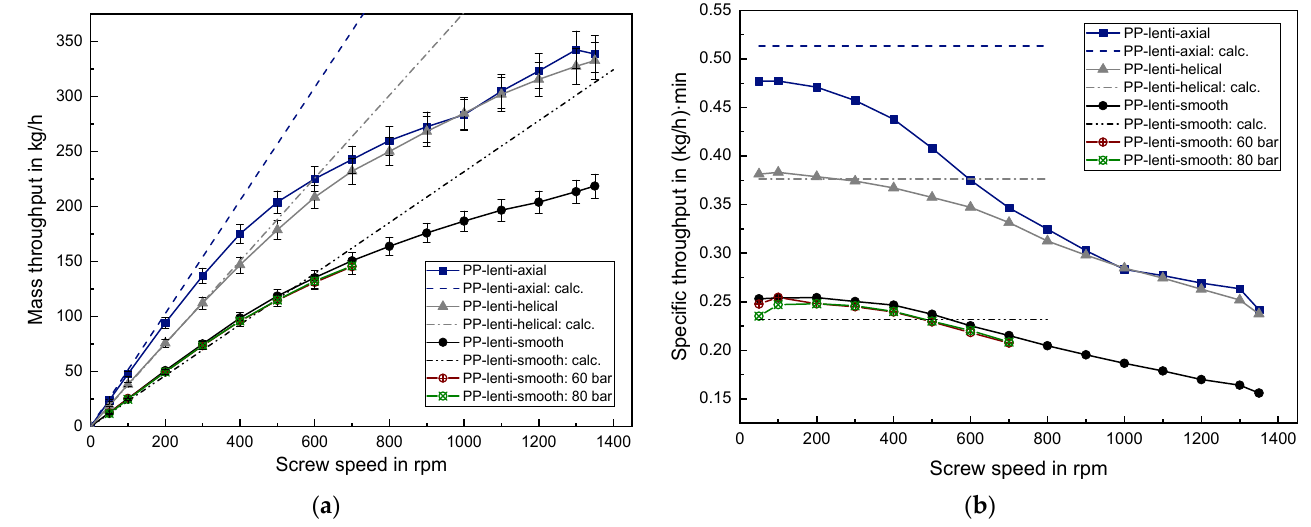
Figure 8. ( a ) Absolute mass throughput and ( b ) specific mass throughput for lenticular PP.